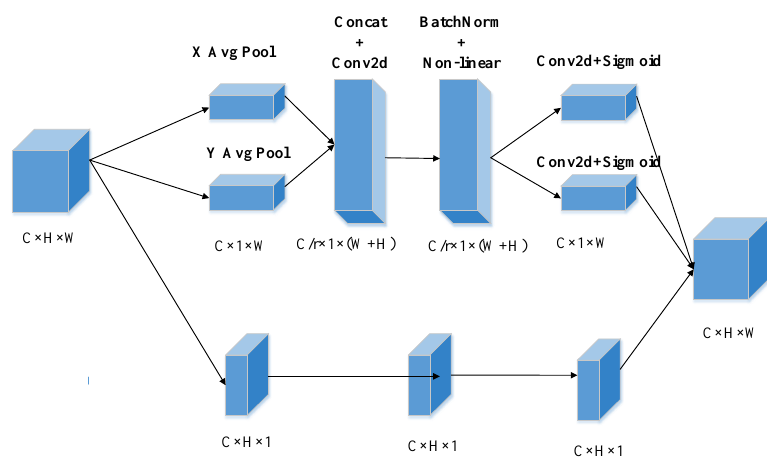
Figure 4. The structure of enhanced feature network BiFPN.